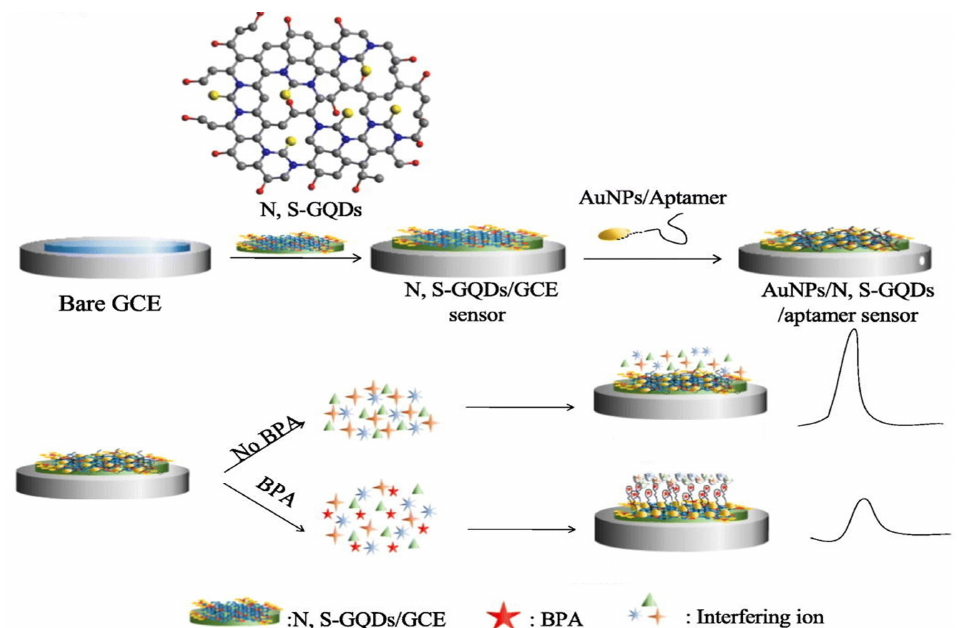
Figure 5. Modification of electrode surface with N,S dopped graphene quantum dots and aptamer- applied detection strategy using ferri-/ferrocyanides as redox marker for the detection of bisphenol A. Adapted with permission from Yao et al. [66]. Copyright © (2020), Elsevier.